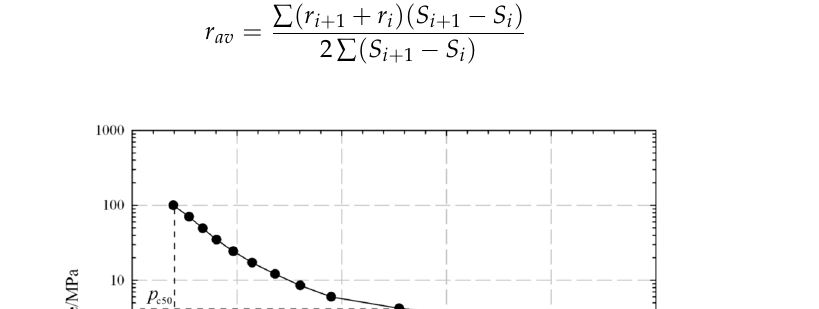
Figure 4. Schematic diagram of gas slippage effect: ( a ) Liquid flow through a capillary; ( b ) Gas flow through a capillary [2].